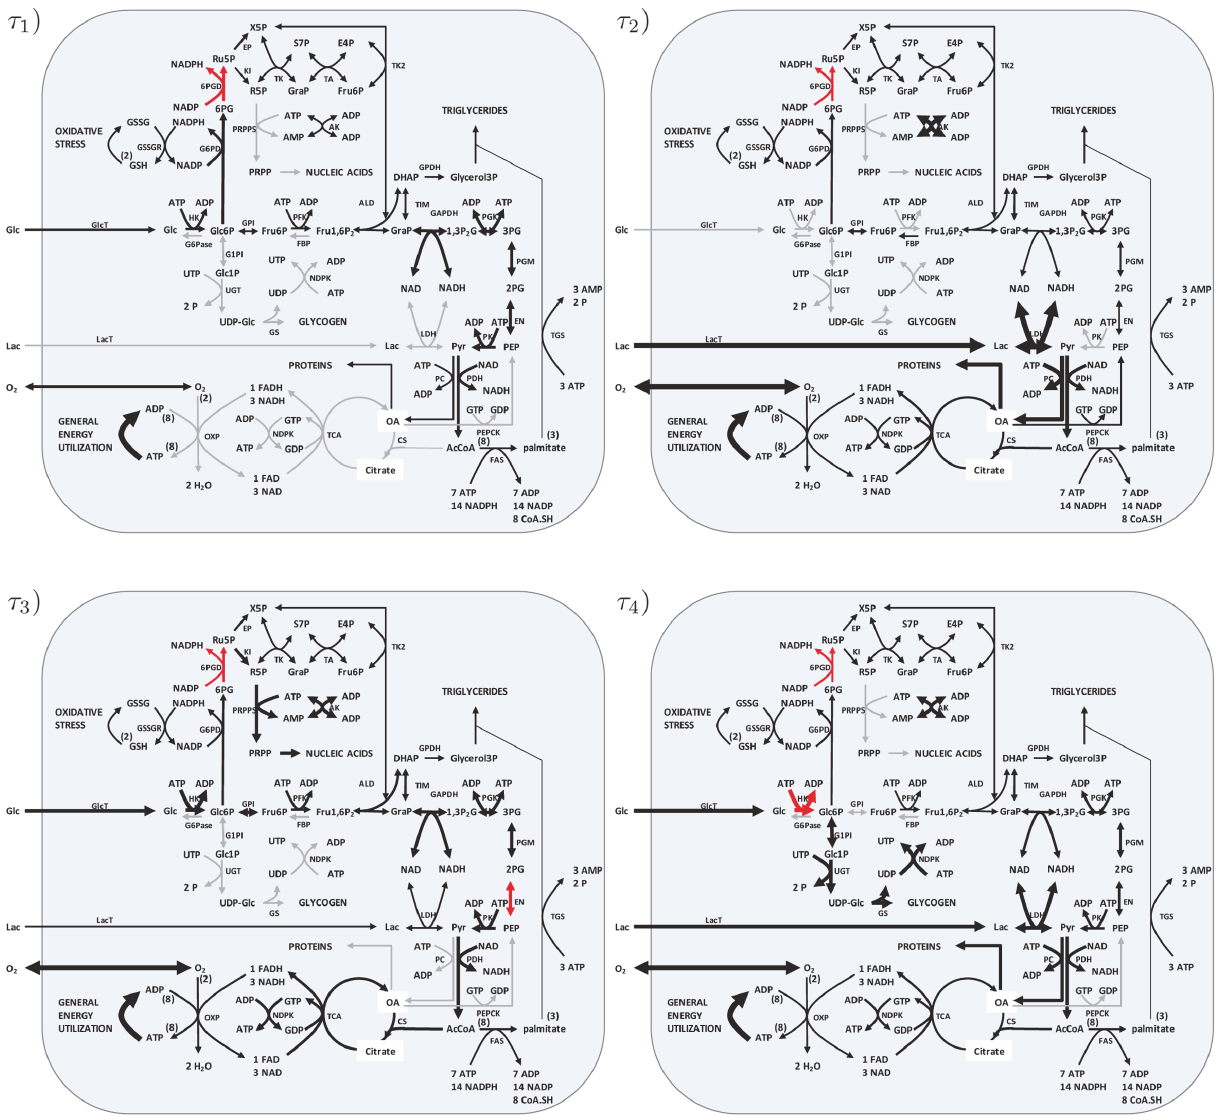
Fig 5. Steady-state flux distributions related to the active gene sets within the four different phases of biomass production. The shown flux distributions correspond to the optimal solution ( iv ) in Table 3. The line width of the arrows corresponds to the flux rate, inactivated reactions are drawn in gray. For the identification of rate limiting reactions, those fluxes which attain their upper bounds are marked in